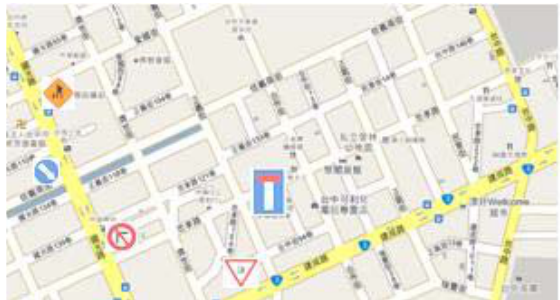
Figure 5. Traffic sign database associated with the Google Maps (after Huang,